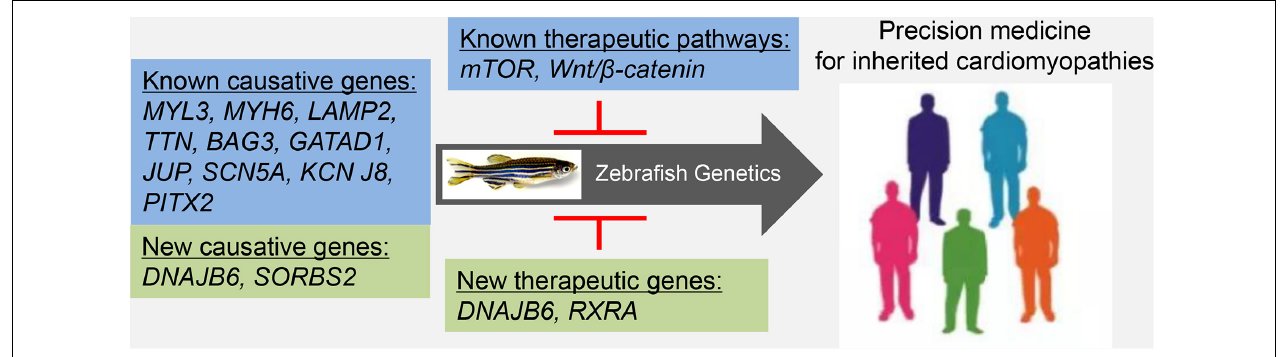
FIGURE 1 | Future perspective. Adult zebrafish can be used to generate genotype-specific cardiomyopathy models, to identify genotype-specific therapeutic pathways, to discover new causative genes, and to discover new therapeutic genes. Discoveries from this efficient vertebrate model might inform the development of precision medicine for inherited